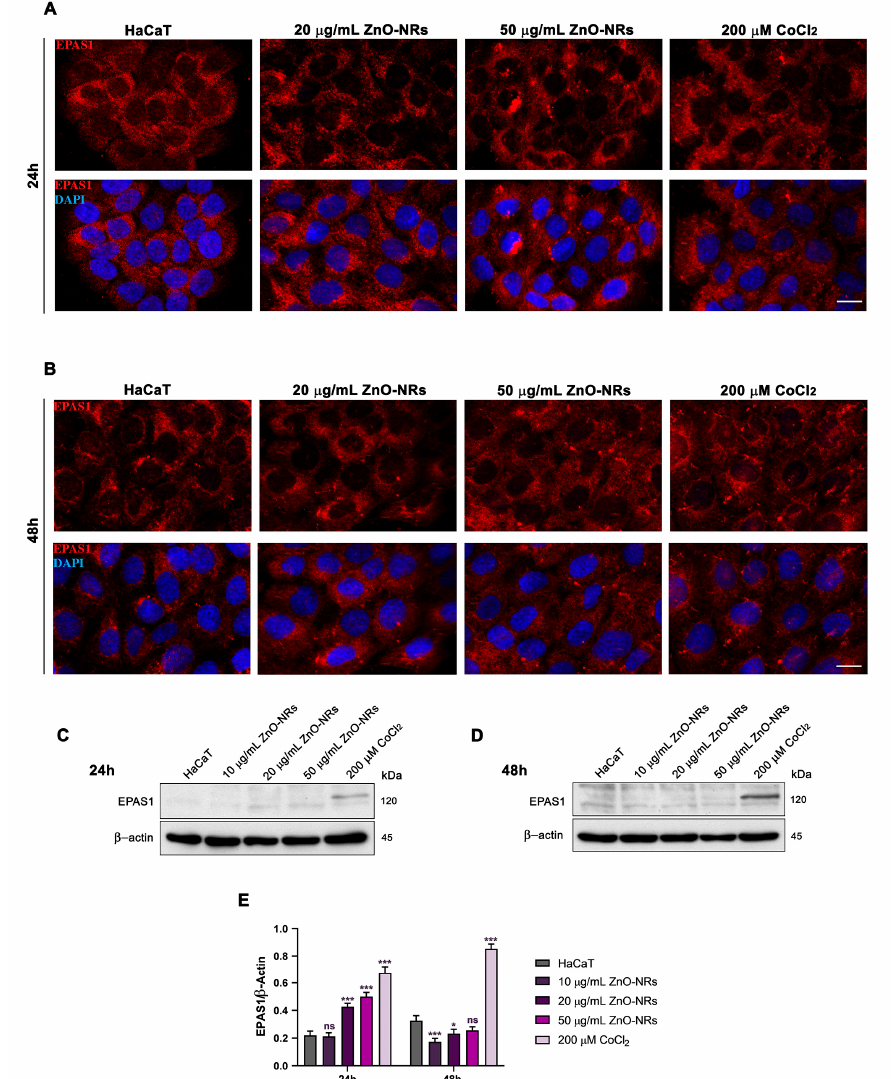
Figure 6. ZnO-NRs’ effects on EPAS1 expression and localization in HaCaT cells. HaCaT cells were either untreated or treated with the indicated ZnO-NR concentration for 24 and 48 h. ( A ) EPAS1 nuclear translocation (red fluorescence) after 24 h treatment with 20 and 50 µ g/mL ZnO-NRs. Nuclei were stained with DAPI (blue fluorescence), 40 × magnification. ( B ) EPAS1 nuclear translocation (red fluorescence) after 48 h treatment with 20 and 50 µ g/mL ZnO-NRs. Nuclei were stained with DAPI (blue fluorescence), 40 × magnification. ( C , D ) EPAS1 protein expression after 24 and 48 h treatment with 10, 20, and 50 µg/mL ZnO-NRs. ( E ) Densitometric analysis of EPAS1 protein expression after 24 and 48 h treatment with 10, 20, and 50 µg/mL ZnO-NRs. Experiments were repeated three times. * p < 0.05, and *** p < 0.001. ns, not signi fi cant. In all experiments, hypoxia, induced by 200 µM CoCl 2 , was used as positive control. β -actin was used as loading control. MCF-7 cells have a high basal EPAS1 expression level that is further increased by ZnO-NRs after 24 h and 48 h (Figure 7).